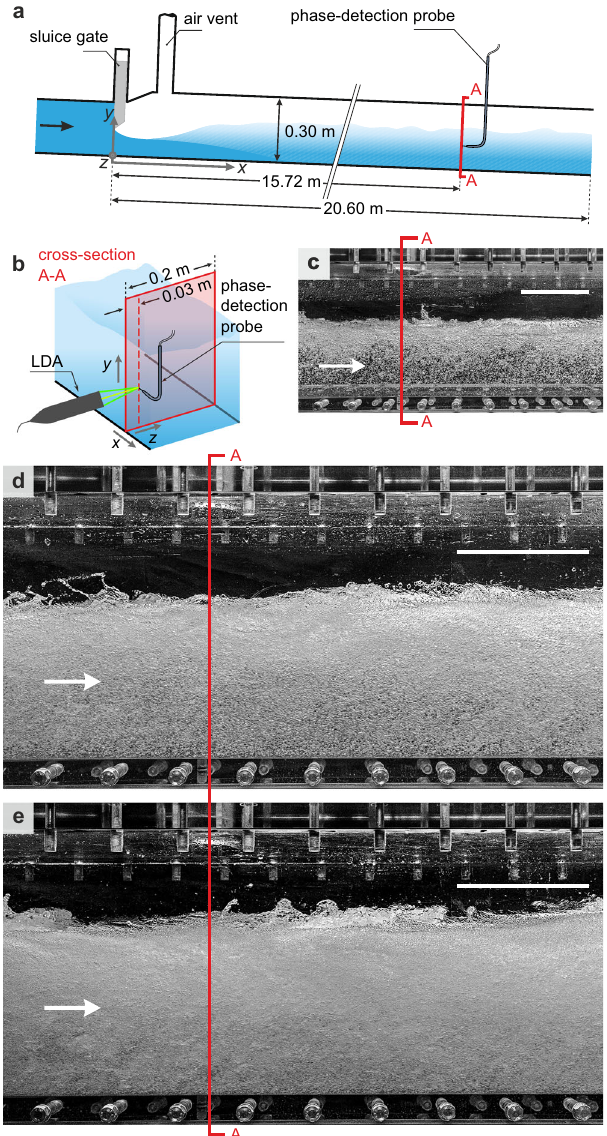
Fig. 1 Illustration of the experimental setup and fl ow pattern. a Longitudinal sketch. b Measurement cross-section and LDA setup. High- velocity air – water fl ow at the measurement location for c Re = 0.9 ⋅ 10 6 , d Re = 1.3 ⋅ 10 6 , e Re = 1.6 ⋅ 10 6 , scale bar in ( c – e ) corresponds to 15